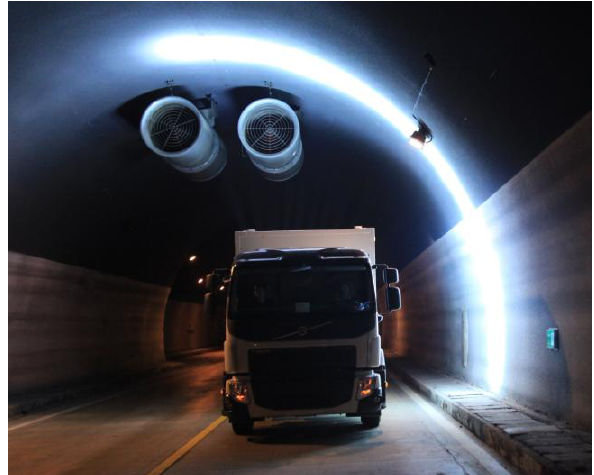
Figure 3 Operational mode of Mobile Tunnel Mapper